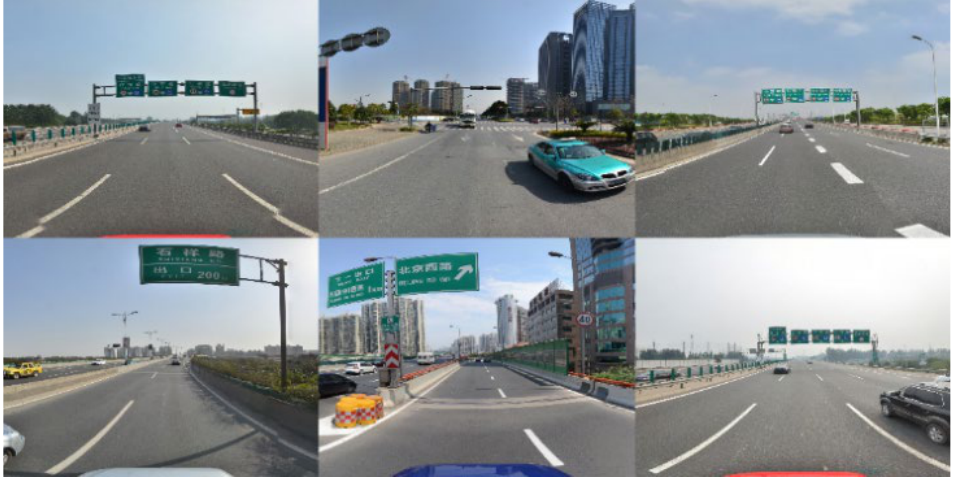
Figure 7. Sample images of the TT100K dataset.